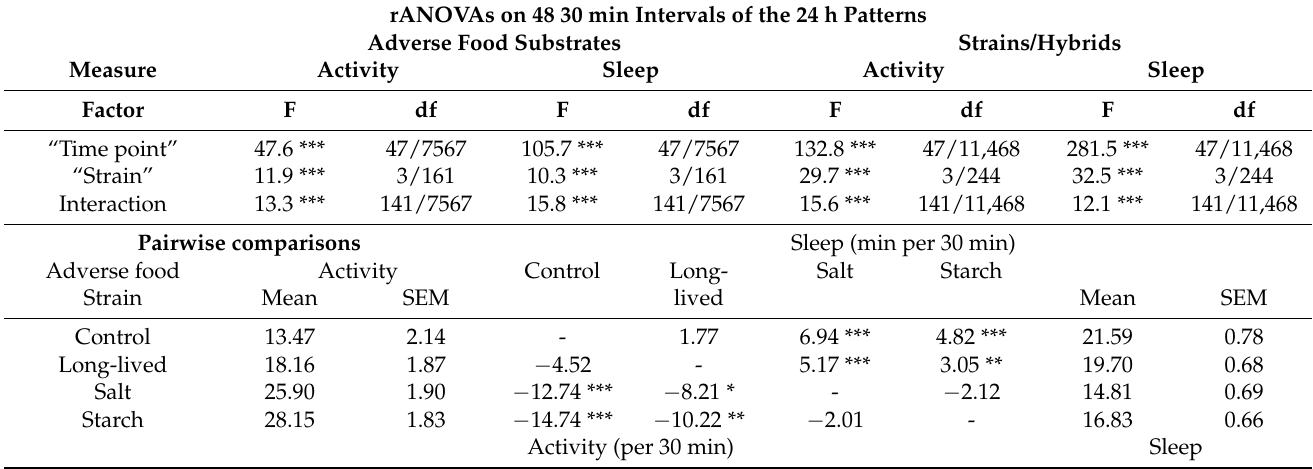
Table 2. Three-way rANOVAs of locomotor activity and